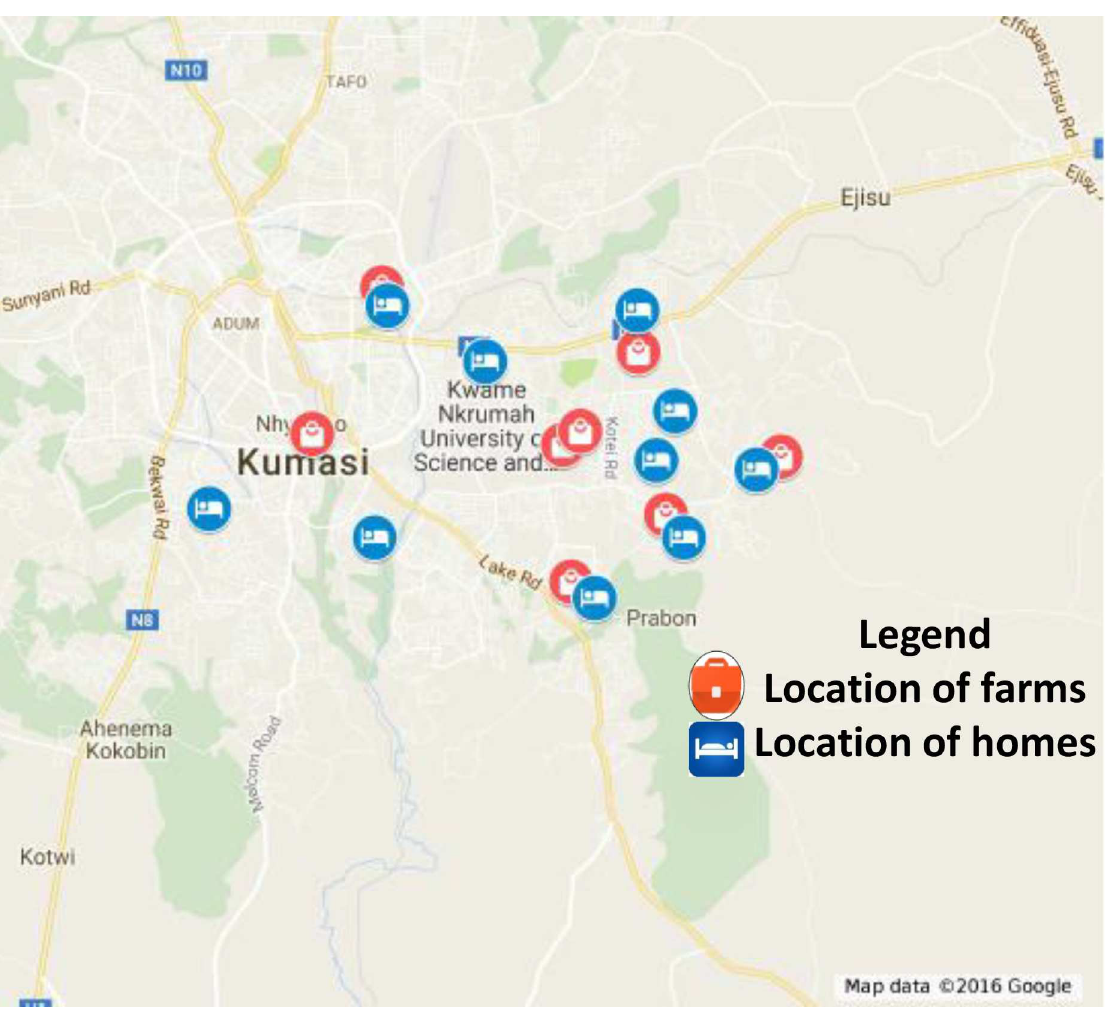
Fig 1. A map of Kumasi showing the location of the wastewater farms and homes of the farmersand control (courtesy Google Maps).